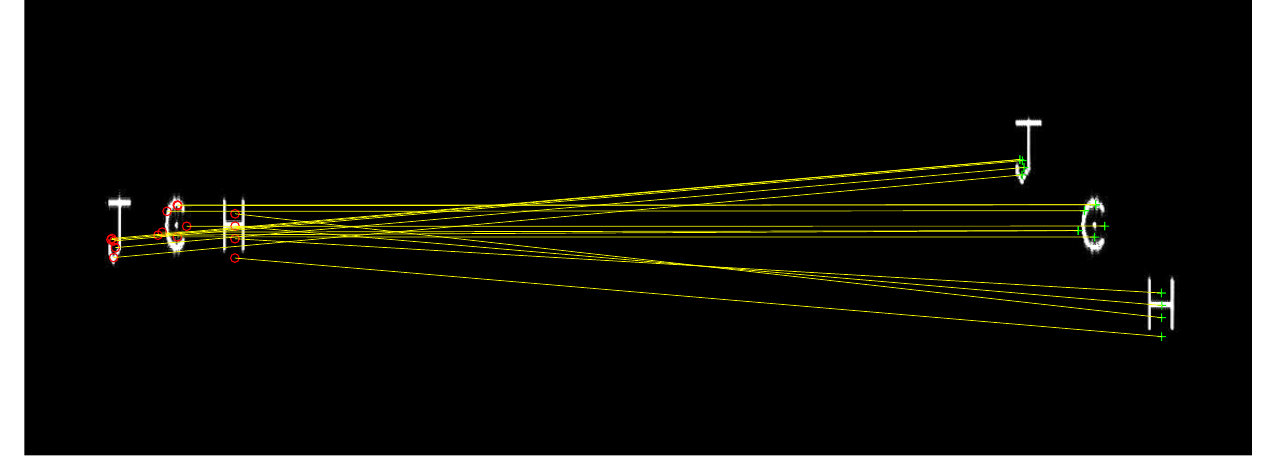
Figure 9. Imaging results of two different sub-apertures. ( a ) Result of the slave image; ( b ) result of the master image.